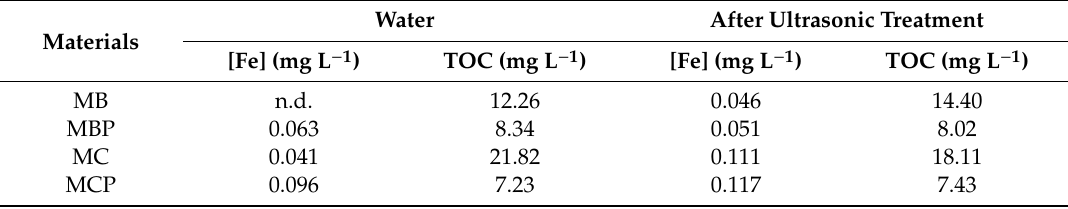
Table 1. Fe and organic carbon released from materials before and after ultrasonic treatment.